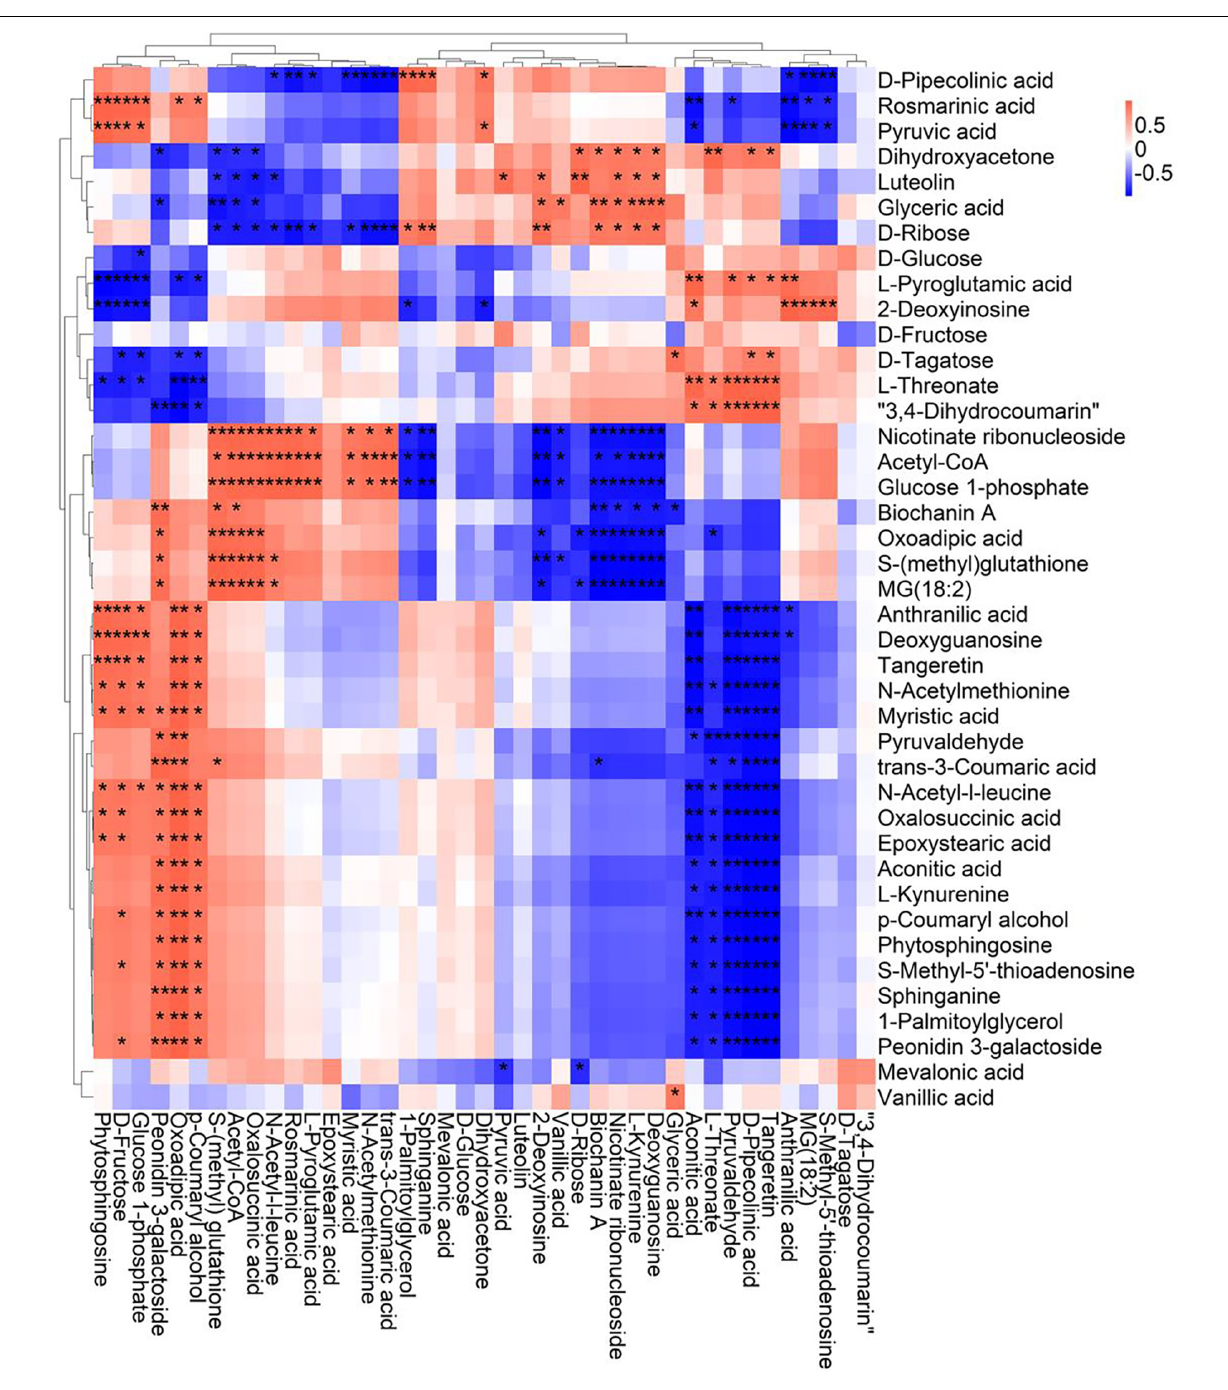
FIGURE 7 | Correlation analysis of TS-DN3 leaf metabolites subjected to spaceflight treatment. A correlation matrix was generated using Pearson’s correlation on six biological replicates of CK and SP-treated plants. Red color shows positive correlation whereas blue color represents negative correlation among the metabolites under spaceflight treatment. ** and * indicate significant difference at p < 0.01 and p < 0.05 by Pearson’s correlation test,